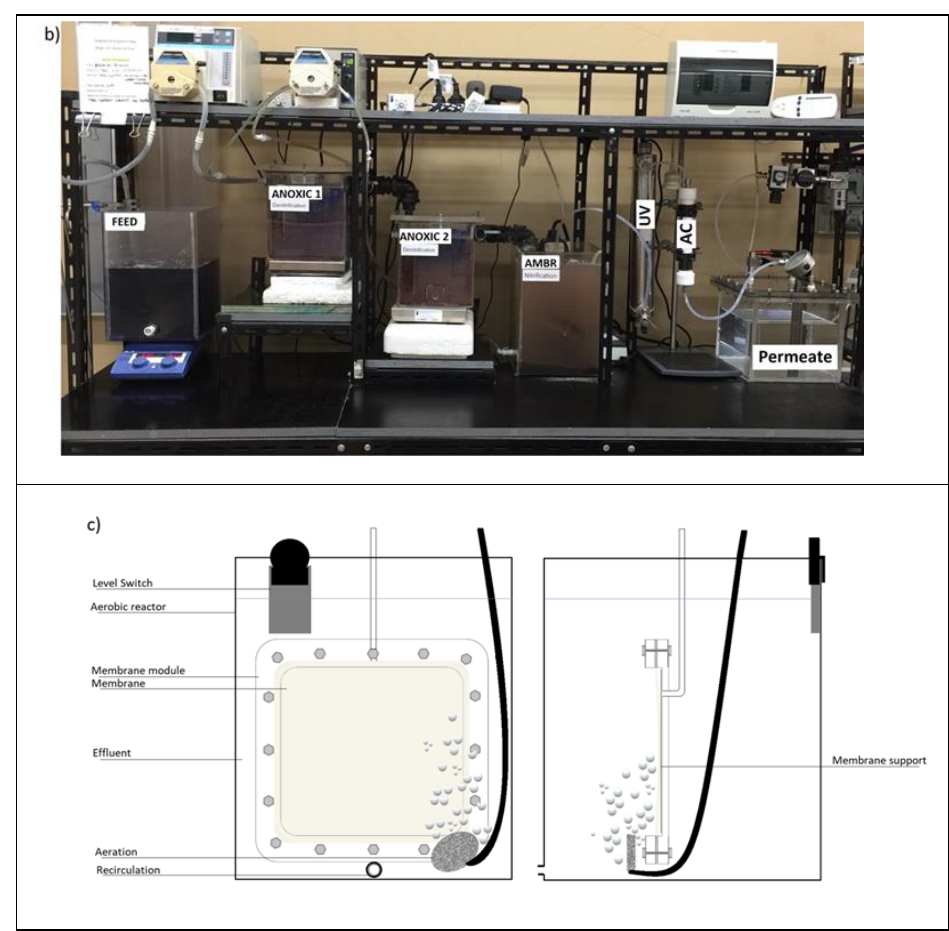
Figure 1. Experimental setup: ( a ) schematic, ( b ) laboratory setup, and ( c ) frontal and side views of membrane in the aerobic tank.